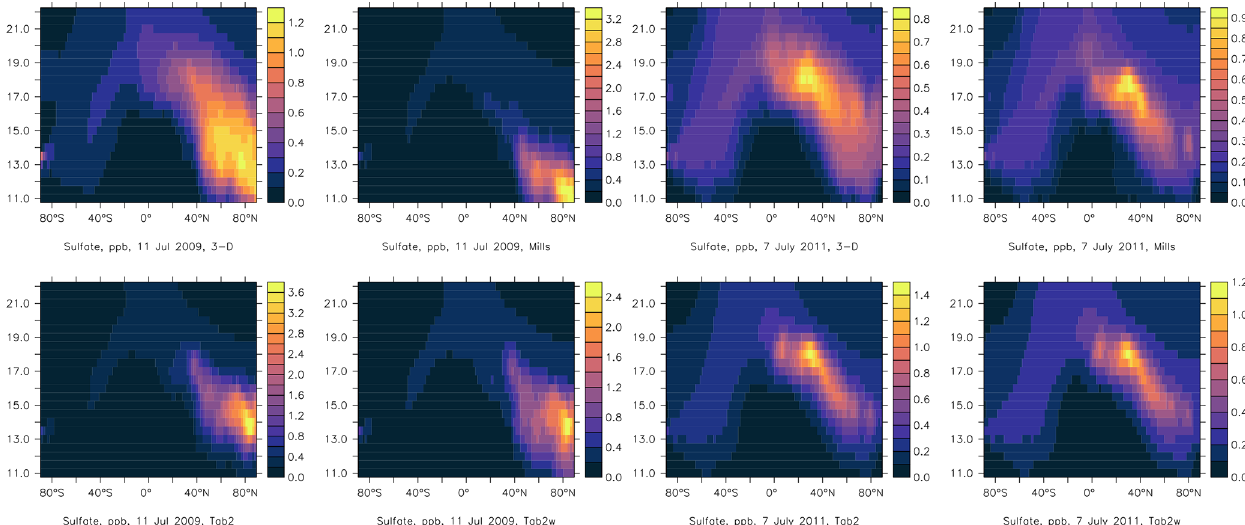
Figure C3. Like Fig. C2 but for sulfate in the accumulation mode.